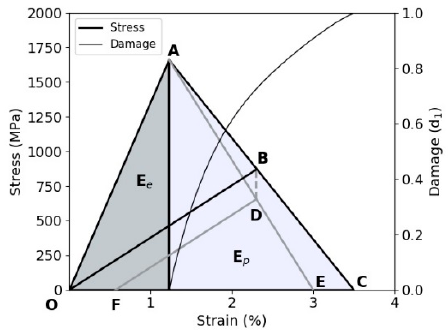
Figure 12. Constitutive model behaviour in tensile failure modes [22] (permanent strain (OF); irreversible stress (BD)).